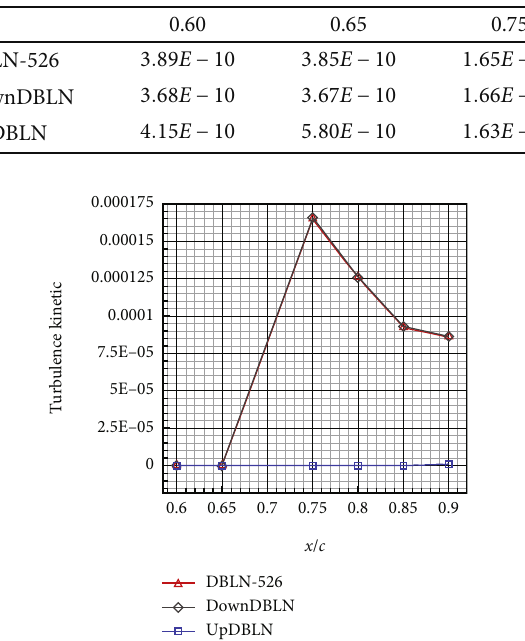
Figure 31: Turbulence kinetic ( Re = 0 : 8 E 6 , α = 0 ° ). Table 9: Changes of pressure and friction coe ffi cients